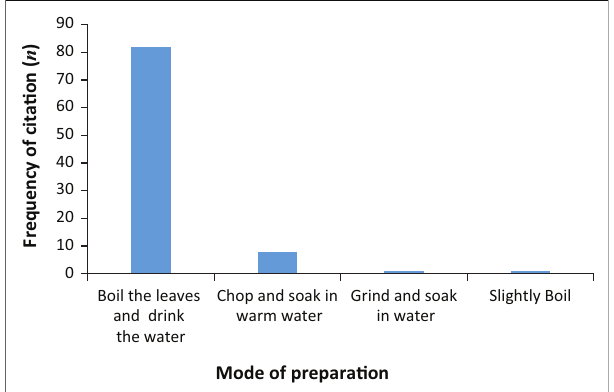
FIGURE 3: Mode of preparation for indigenous leafy vegetables.